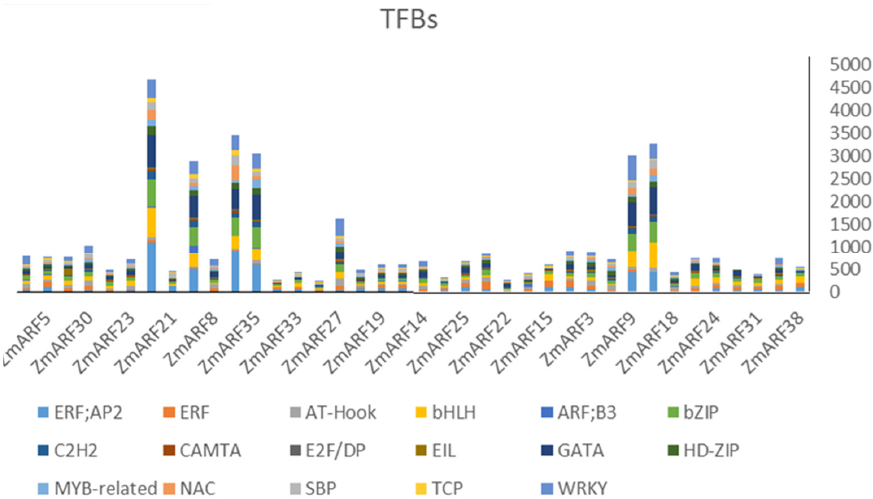
Figure 5. Transcription factor binding sites detected in the upstream of promoter regions and their frequencies in each